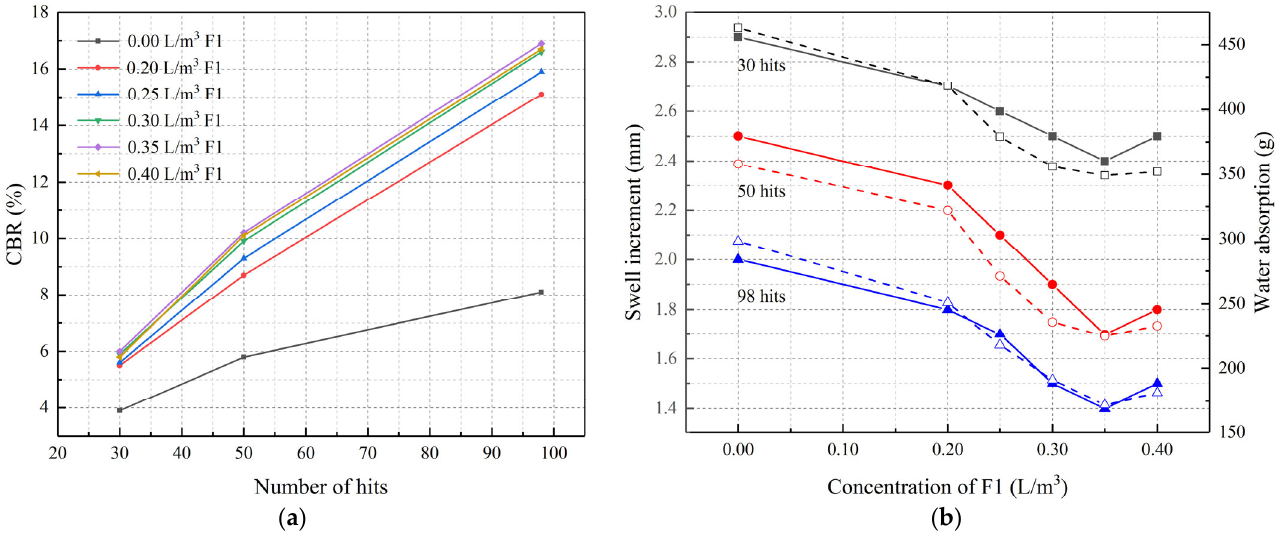
Figure 5. CBR test results. ( a ) The relationship between CBR and the number of hits; ( b ) the relationship between the concentration of F1 and swell increment/water absorption.